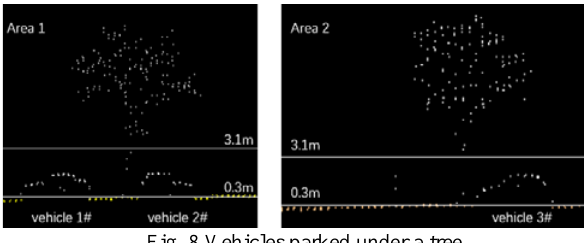
Fig. 8 Vehicles parked under a tree